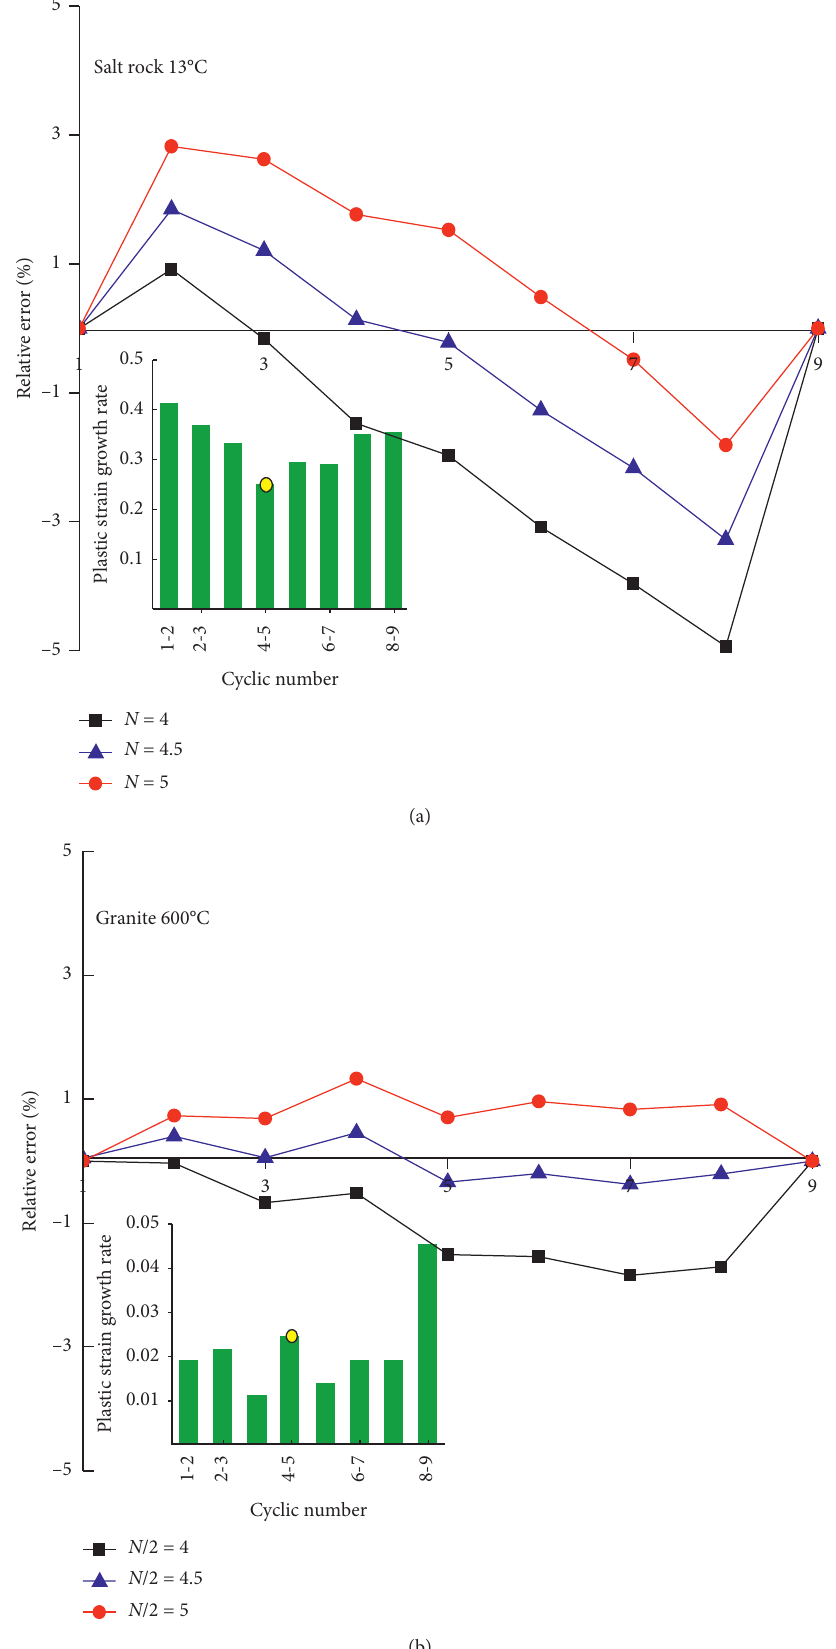
Figure 12: Relative error of upper